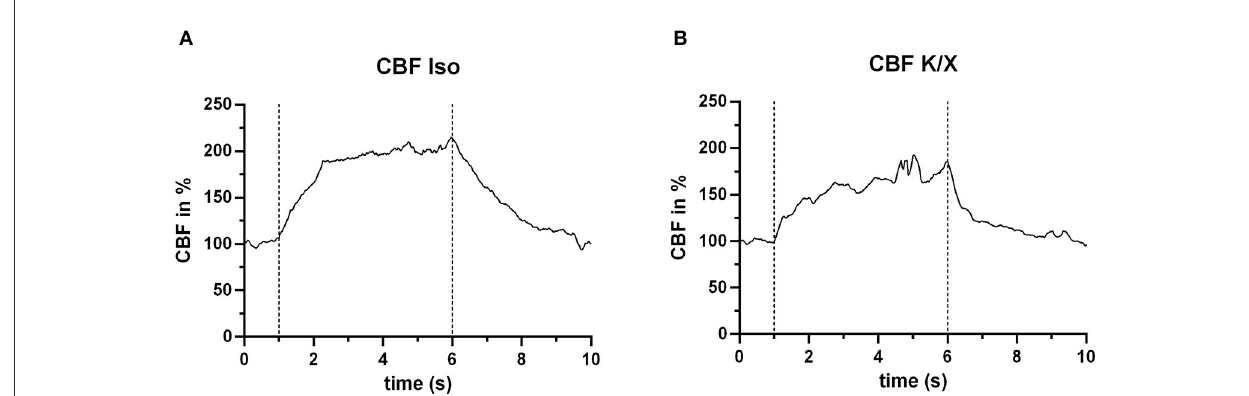
FIGURE5 CBF increase during hypercapnia. In both anesthetic protocols, an increase in blood flow in response to hypercapnia (within the dashed lines) was measured. For this example, n = 2 animals were used. (A) Example under Iso anesthesia ( n = 1 animal), showing a mean increase in CBF of 84.2% (averaged for the entire hypercapnia phase between the dashed lines), and (B) example ( n = 1 animal) under K/X anesthesia, with a mean CBF increase of